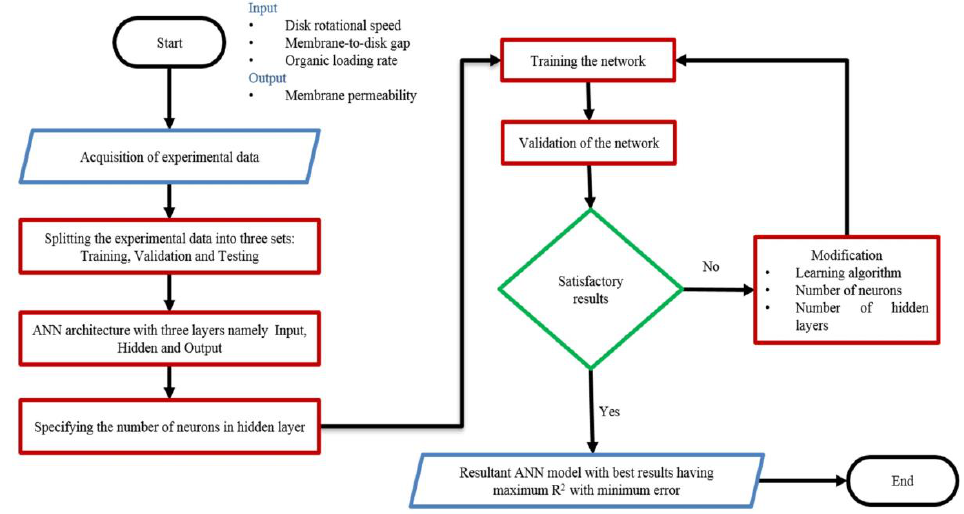
Figure 2. Process flow of artificial neural networks modelling.